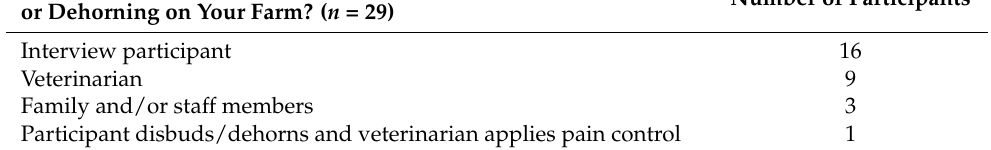
Table 1. A description of the disbudding and dehorning practices for 29 Ontario dairy farmers. This information is included for reference and to provide additional context to the